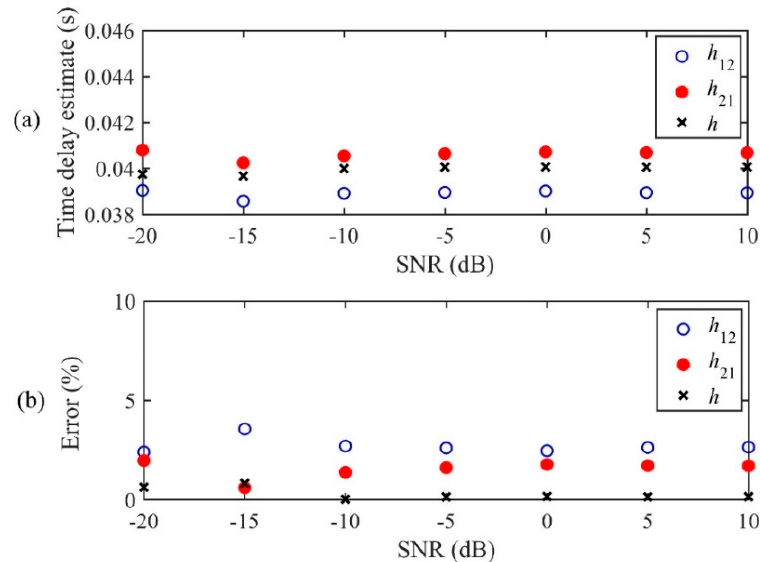
Figure 8. Effect of background noise on the performance of the adaptive methods for TDE: ( a ) Time delay estimate; ( b ) relative error.